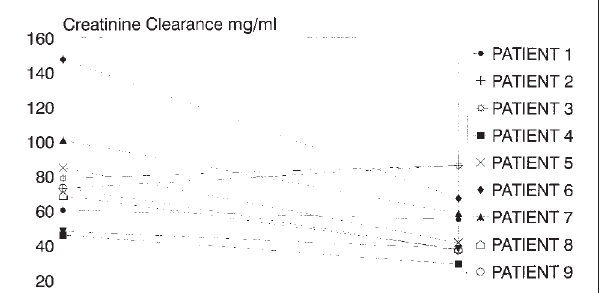
Figure 2) Baseline and ending creatinine clearance values for